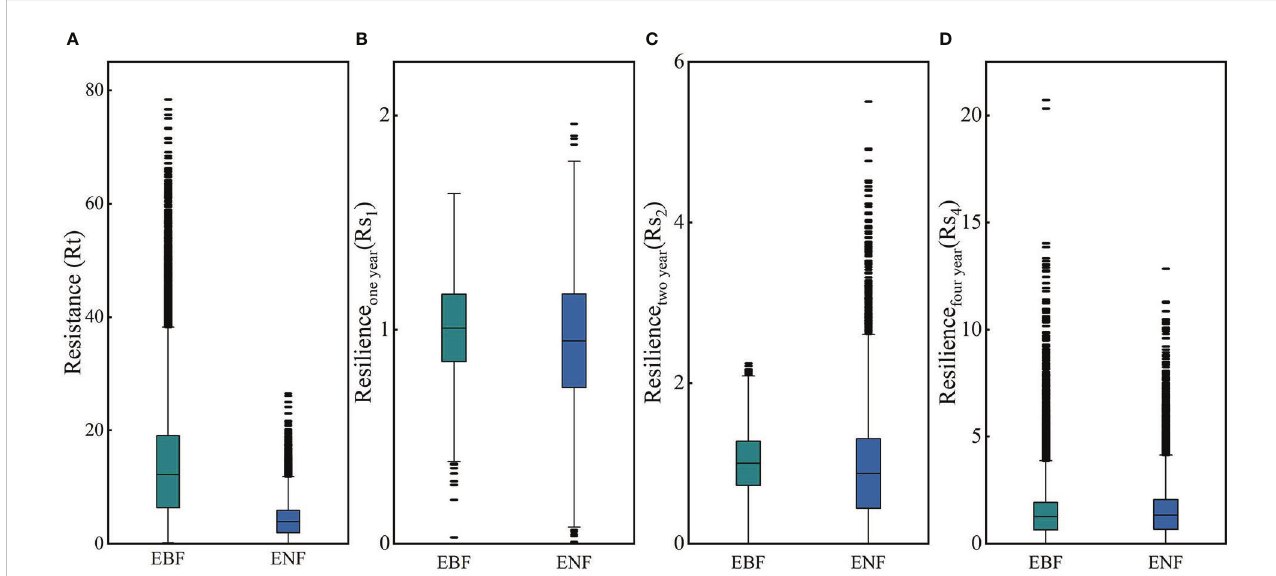
FIGURE 7 Resistance of the EBF and ENF to drought in 2011 (A) , and their resilience to the 2011 extreme drought after the fi rst (B) , second (C) , and fourth (D)